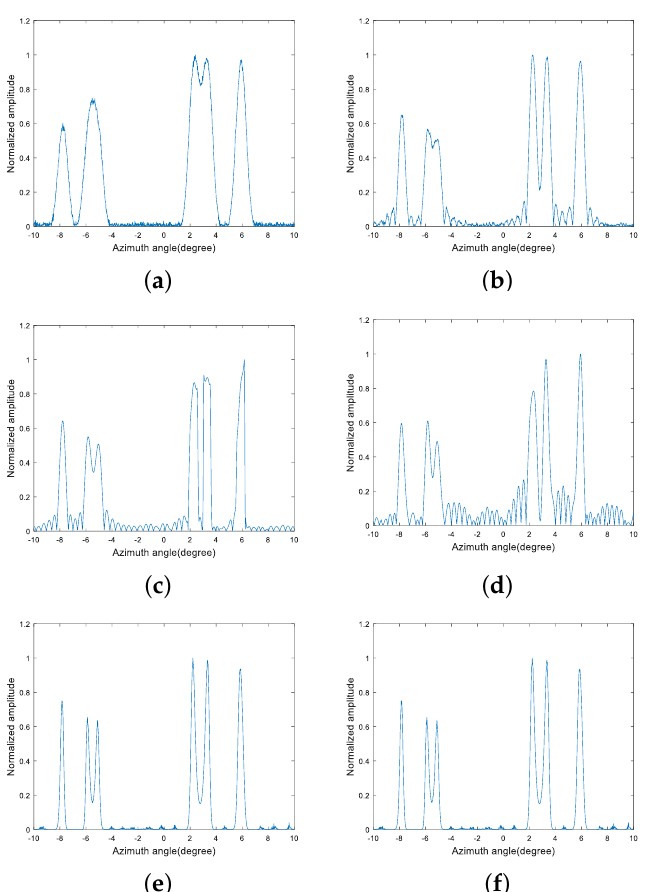
Figure 2. RBM echo and super-resolution processing results with different methods. ( a ) RBM raw echo in SNR = 30 dB. ( b ) The processing result using the REGU method. ( c ) The processing result using the TV method. ( d ) The processing result using the TSVD method. ( e ) The processing result using the PML method. ( f ) The processing result using the IPML